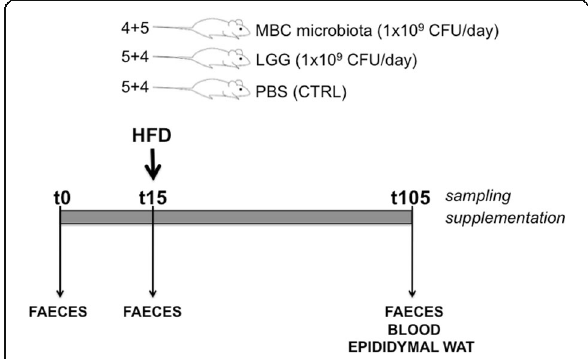
Fig. 1 Experimental design. Six-week-old C57BL/6J male mice were randomly assigned to three experimental groups (four or five animals per group). The mice were fed a standard diet and orally supplemented daily with MBC microbiota, LGG, or PBS (CTRL). After 15 days, the mice were shifted to HFD while continuing bacterial or PBS supplementation for 90 additional days. At the end of the experimental period, blood and epididymal WAT were collected. Faeces were sampled for gut microbiota analysis at the indicated time points: t0, t15, and t105. The experiment was replicated once, and the number of mice in each group for each of the two repetitions is